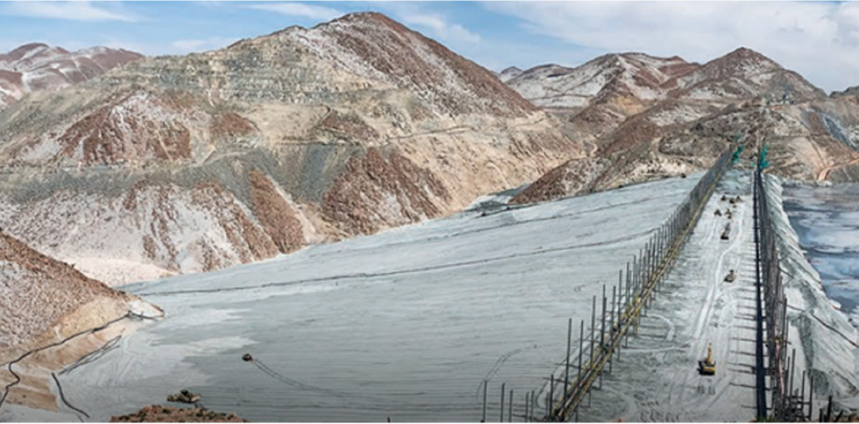
Figure 6. Conventional Tailings Technology—Quebrada Enlozada TSF Cerro Verde Mine Peru [8].